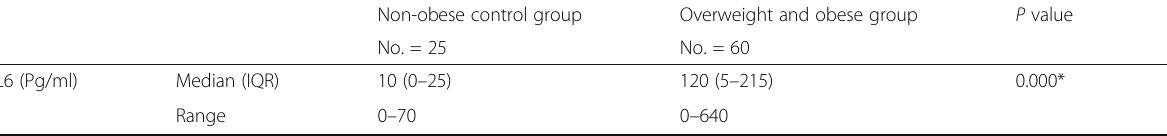
Table 3 Comparison of circulating levels of IL6 in control group and study group Non-obese control group Overweight and obese group P value Sig No. = 25 No. =